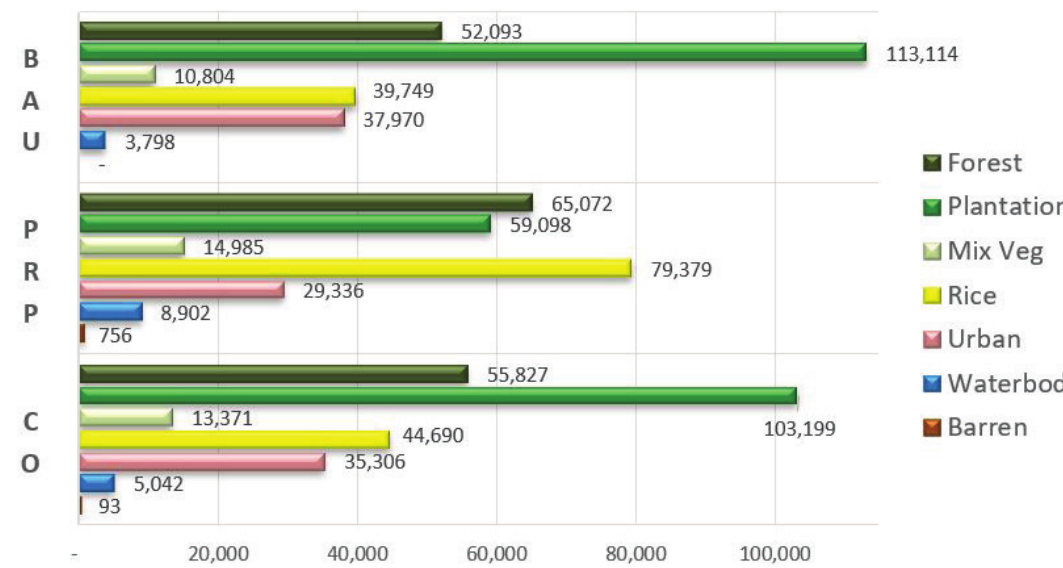
Figure 5. The coverage area of simulated landuse of BAU, PRP and CO scenarios (ha) by 2040.